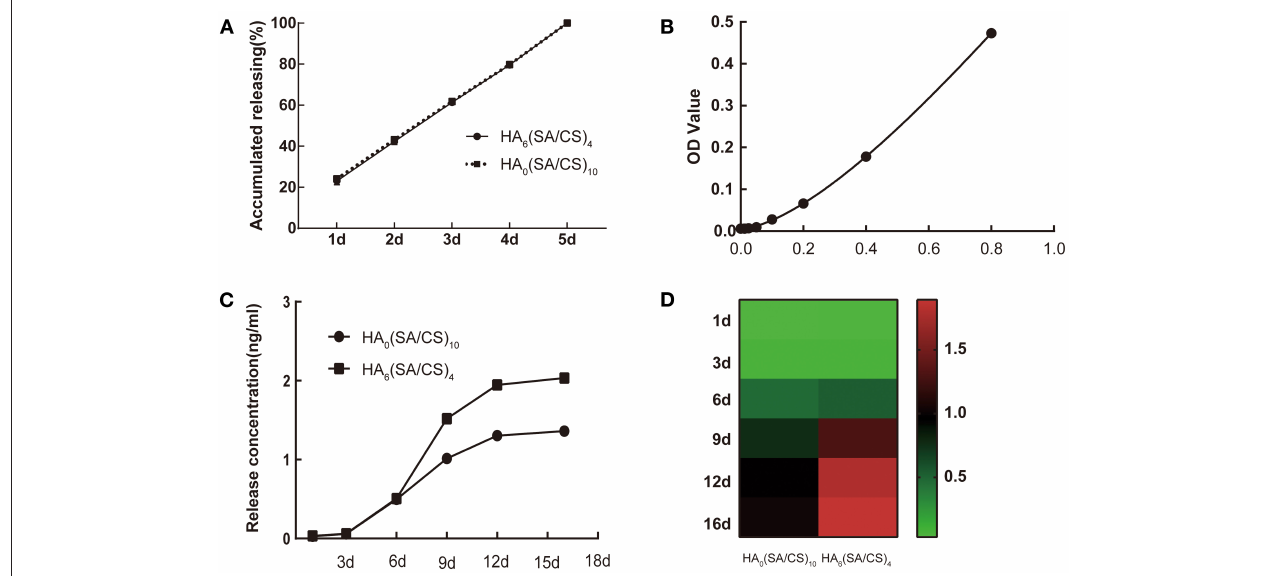
FIGURE 5 | (A) The release curve of VAN on HA 0 (SA/CS) 10 scaffold and HA 6 (SA/CS) 4 scaffold. (B) A standard ELISA curve for VEGF. (C) The VEGF release curves of HA